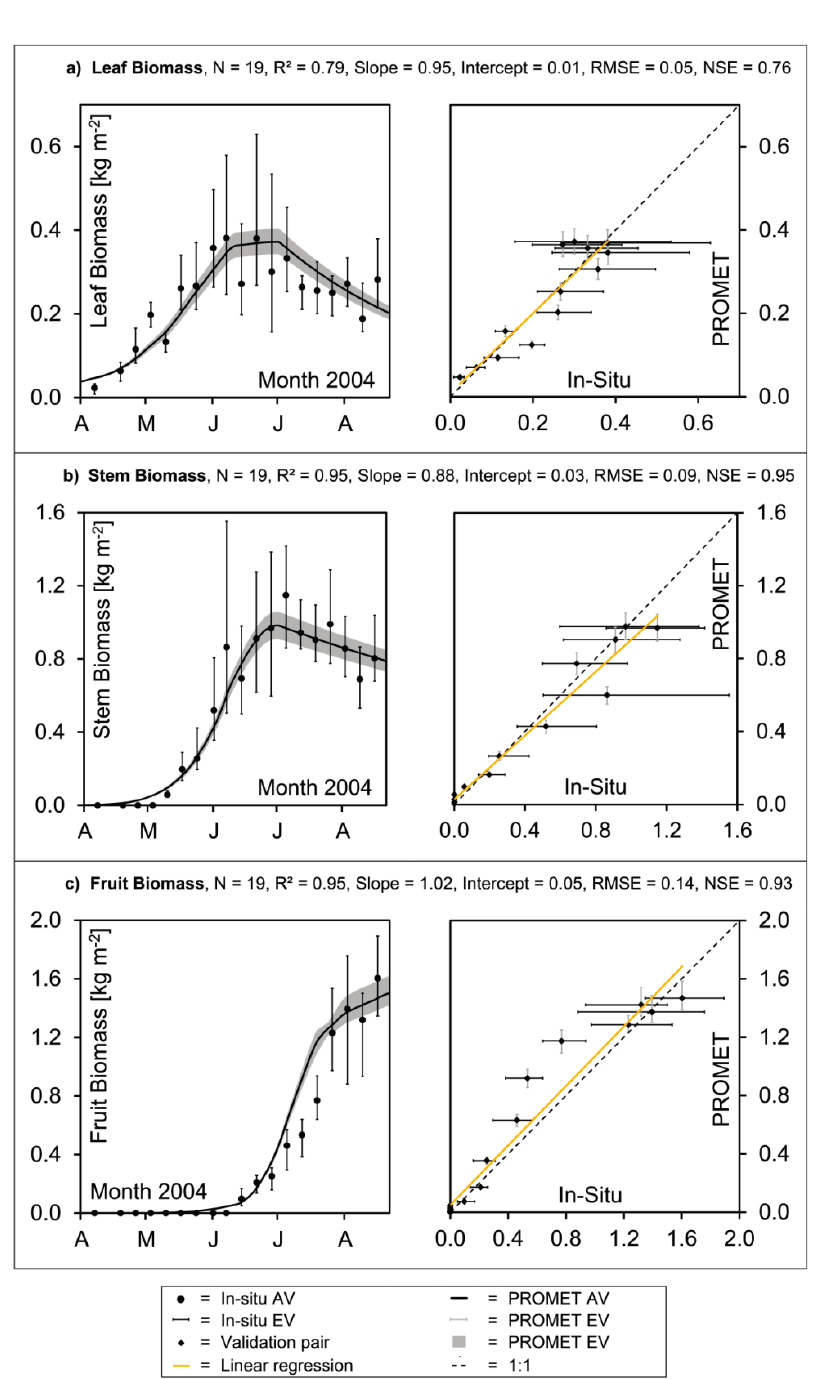
Figure 6. Validation of aboveground dry biomass accumulation of winter wheat in southern Germany: Modelled values vs. in situ measurements: ( a ) leaf biomass, ( b ) stem biomass, ( c ) fruit